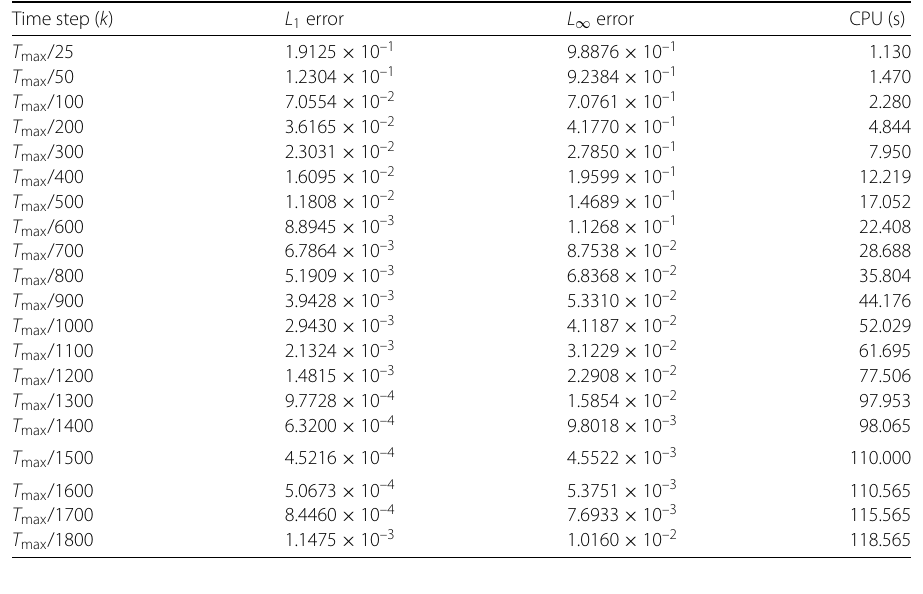
Table 7 L 1 and L ∞ errors and CPU time at some different values of time-step size k for Problem 2